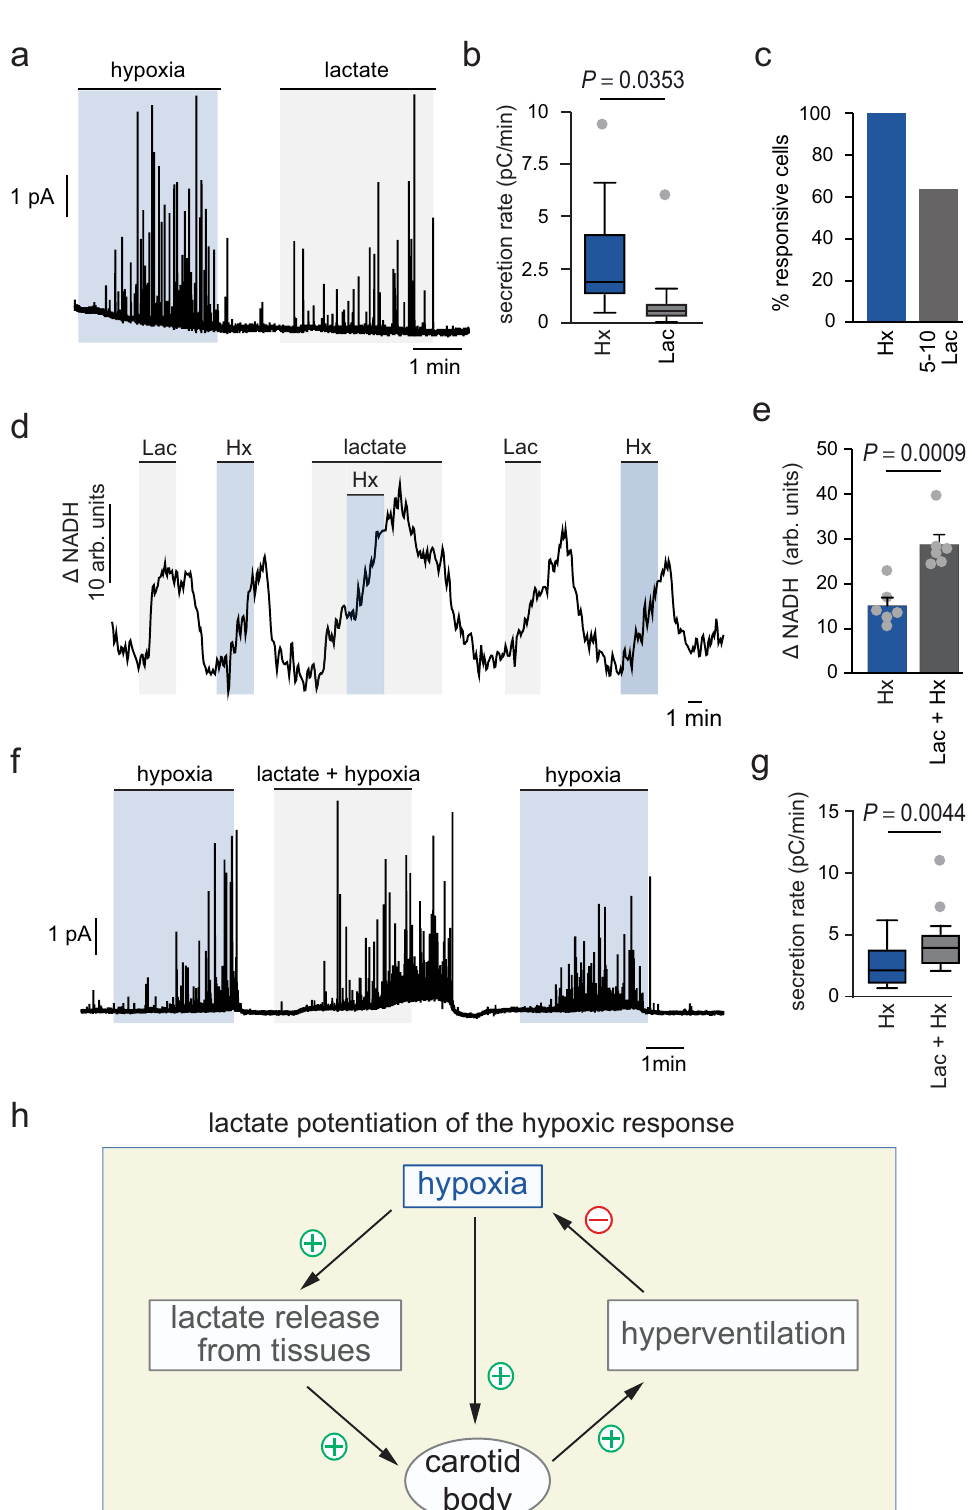
depolarization and opening of Ca 2 + channels (see Fig. 6g) and, therefore, have additive effects on glomus cells. The potentiation of CB activation by lactate during hypoxia facilitates a rapid re fl ex ventilatory compensation of hypoxemia and, secondarily, blunts peripheral lactate release (Fig. 7h). This adaptive response could minimize potential deleterious effects due to lactate release (e.g., metabolic acidosis) or excessive lactate uptake by cells.